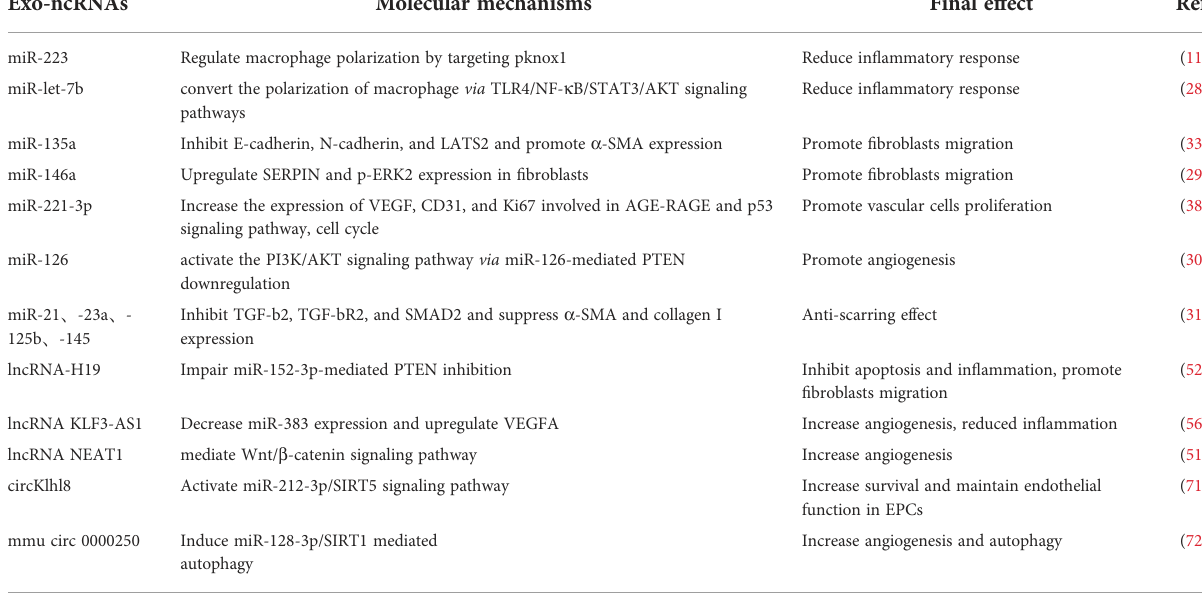
TABLE 1 Molecular mechanisms and therapeutic potential of exosomal ncRNAs involved in diabetic wound healing. Exo-ncRNAs Molecular mechanisms Final effect